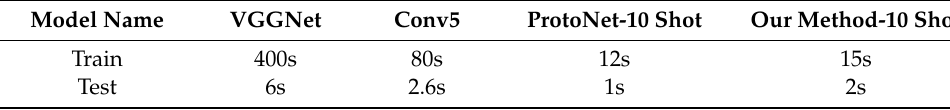
Table 4. Comparison of time consumption of different models.